Question: Identify the chart type used in this figure.
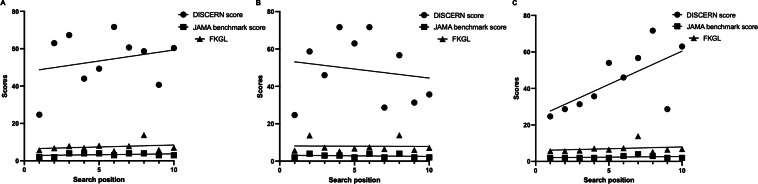
Answer: scatter